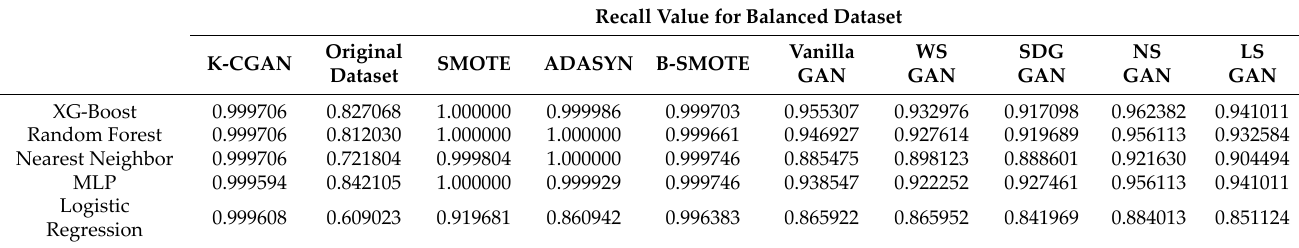
Table 9. Recall values for classification methods for balanced dataset. Recall Value for Balanced Dataset